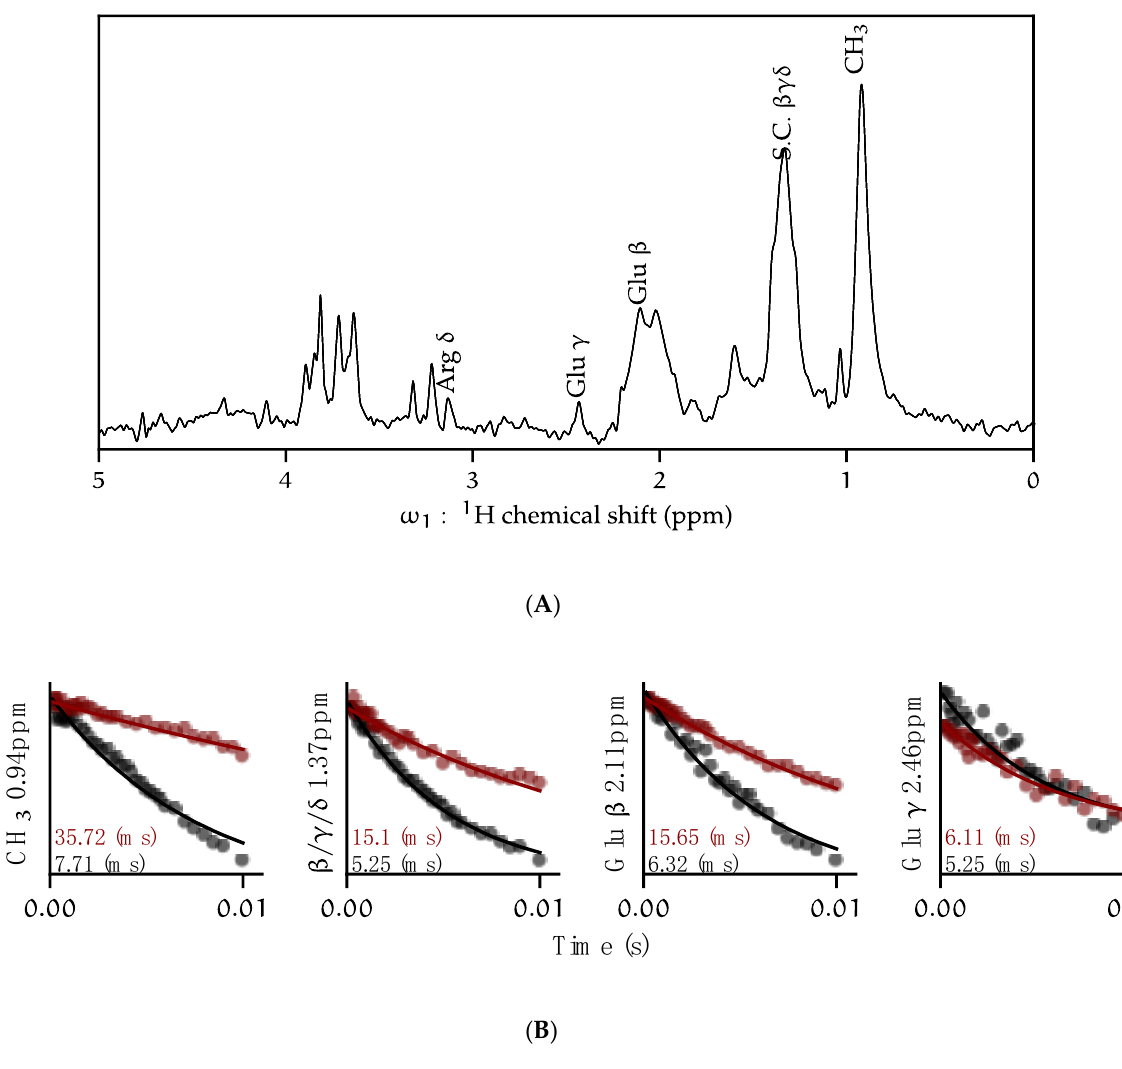
Figure 6. The T 2 relaxation time is lengthened due to fractional deuteration of KcsA. ( A ) 1 H- 13 C double-INEPT (1D refocused HSQC) spectrum of U- 1 H, 13 C, 15 N-KcsA in proteoliposomes (9:1 DOPE-DOPS) with peak annotations. Assignments are based on 2D and 3D data. ( B ) 13 C relaxation of selected peaks from 1D double-INEPT for fully protonated KcsA (black), and fractionally deuterated KcsA (red). Both samples U- 13 C, 15 N at pH 4, 50 mM K + , 9 kHz MAS, 308 K.